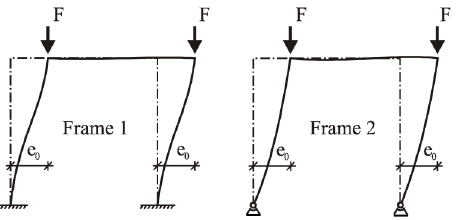
Fig. 3. Buckling of Frame 1 and Frame 2